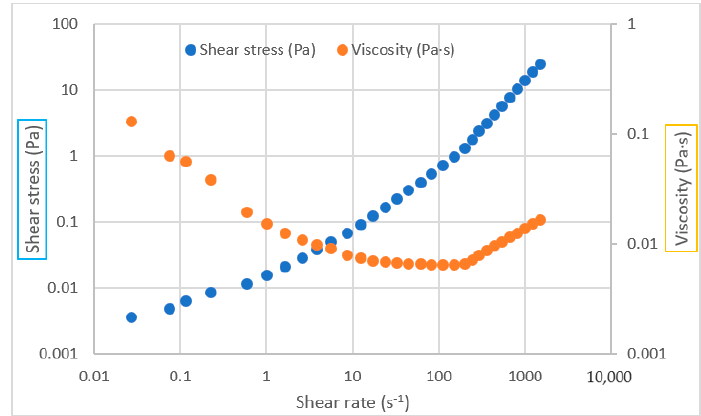
Figure 8. Rheological properties of the 20%—PVP K30/sterile water sample.